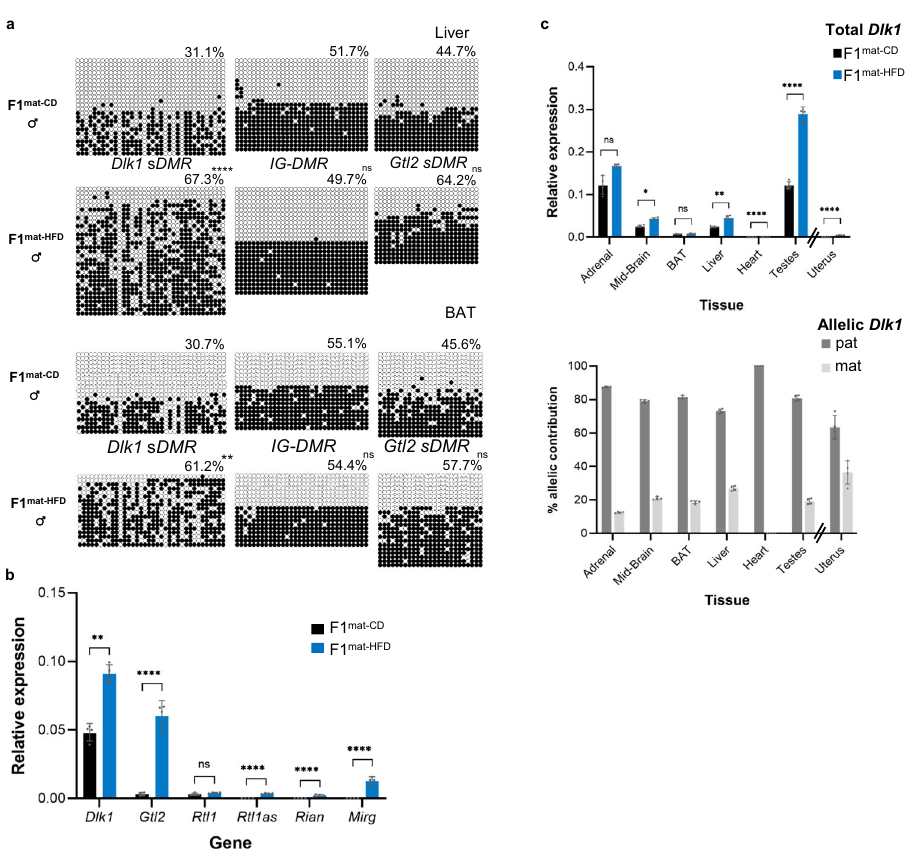
Fig. 4 Altered DNA methylation and allelic mis-expression of Dlk1 in offspring exposed to HFD in utero. a DNA bisulphite methylation analysis at Dlk1 sDMR , IG-DMR and Gtl2 sDMR in liver (upper) and brown adipose tissue (BAT) (lower) from representative male P56 F1 mat-CD and F1 mat-HFD animals. In liver and BAT, hypermethylation was detected at Dlk1 sDMR , increased methylation was observed at the Gtl2 sDMR (not statistically signi fi cant), but IG- DMR was unchanged. Closed circles indicate methylated CpGs, open circles un-methylated CpGs. Each row represents an individual clone. Percentages indicate total methylation level of the region from two wt and two KI mat animals. (Kolmogorov-Smirnov test comparing clonal methylation levels, using Holm- Š ídák ’ s correction for multiple comparisons: ** p adj < 0.0055, **** p adj = 6 × 10 − 6 , ns = not signi fi cant). Source data are provided as a Source Data fi le. b Gene expression (QRT-PCR) at the Dlk1-Dio3 cluster in the liver of male P56 F1 mat-HFD (blue) and F1 mat-CD (dark grey) animals. Expression levels for this single tissue comparison were normalised to β -Actin expression. (Bars show the geometric mean of relative expression with geometric SD; N = 4 + 4 individual mice; unpaired two-sided t -tests on delta-Ct values with Holm- Š ídák ’ s correction for multiple comparisons: ** p adj = 0.0067, **** p adj < 0.0001, ns = not signi fi cant). Source data are provided as a Source Data fi le. c Dlk1 expression (QRT-PCR, upper panel) in different tissues from P56 male mice exposed to either control (F1 mat-CD , black) or high-fat diet (F1 mat-HFD , blue). Uterus samples from age-matched female mice were also analysed. Expression levels were normalised to β -Actin , 18S and Hprt . (Bars show the geometric mean of relative expression with geometric SD; N = 4 + 4 individual mice; Two- way ANOVA on delta-Ct values (Tissue p < 0.0001, Diet p < 0.0001, Interaction p < 0.0001); results of Holm- Š ídák ’ s multiple comparisons follow-up test for effect of diet in each tissue are shown: * p adj = 0.013, ** p adj = 0.0042, **** p adj < 0.0001, ns = not signi fi cant). Allelic Dlk1 analysis in F1 mat-HFD mice (lower panel), using primers that distinguish the reporter from the wt allele, showed a reduced contribution for paternal allele expression (dark grey) when compared to maternal allele expression (light grey). (Bars indicate the mean contribution from each allele ±SD; N = 4 + 4 individual mice). Source data are provided as a Source Data fi as compared with F1 mat-CD (Figs. S8d and S8e). At the Dlk1-Dio3 parallel genome-wide single-cell bisulphite sequencing and single- cell RNA-seq (scM&Tseq) (quality control shown in Figs. S7a and S7b) 47,48 . In both groups the anticipated bimodal pattern of DNA hypo- and hypermethylated domains in oocytes 48,49 was retained, with a broadly similar pro fi le assessed over 100-CpG windows ( r = 0.984) (Figs. S8a and S8b). While differences in methylation were detected in 439 differentially methylated 100-CpG tiles (representing approximately 0.2% of genomic tiles) these were dispersed across the genome (Fig. S8c) and principal component analysis (PCA) indicated no obvious separation of oocytes from different groups (Fig. S8a). Among the imprinted gametic DMRs, high levels of methylation of maternal gDMRs and low levels of methylation of paternal gDMRs were well preserved in F1 mat-HFD oocytes (Fig. 6a) and we did not detect signi fi cantly increased variation or anomalous gDMR methylation of F1 mat-HFD oocytes fold from the mean standard deviation) (Fig. S9a and